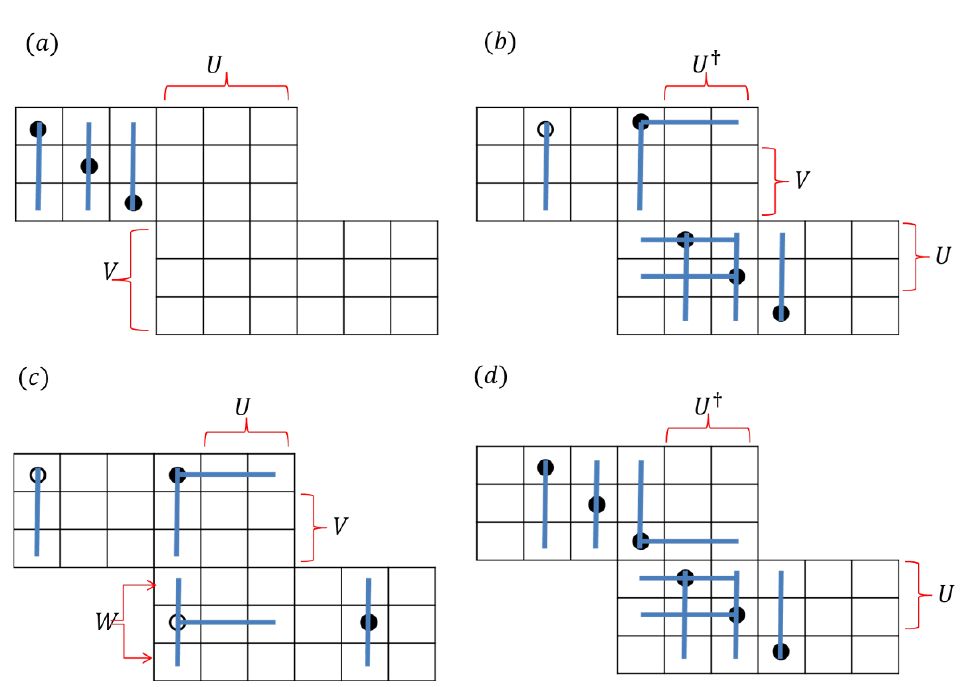
Figure 2 . This (cid:12)gure shows four possible vacua for a theory with G = SU(3) 3 . Full and empty dots represent q and ~ q getting VEV respectively. The lines represent hypermultiplets which are swallawed by gauge multiplets via the Higgs mechanism. In (a) there is a baryon for the (cid:12)rst SU(3) and nothing for the rest. In (b) there is a meson for the (cid:12)rst SU(3) and baryons for the two other SU(3)s. In (c) there is a meson for every SU(3) and in (d) a baryon for every SU(3) factor. Up to the discrete Z factor, the residual gauge symmetries in these four vacua are: (a) SU(3) 2 , (b) j c j SU(2) 2 , (c) SU(2) 3 , (d) SU(2). The way the residual gauge transformations act on the di(cid:11)erent indices is shown explicitly on the